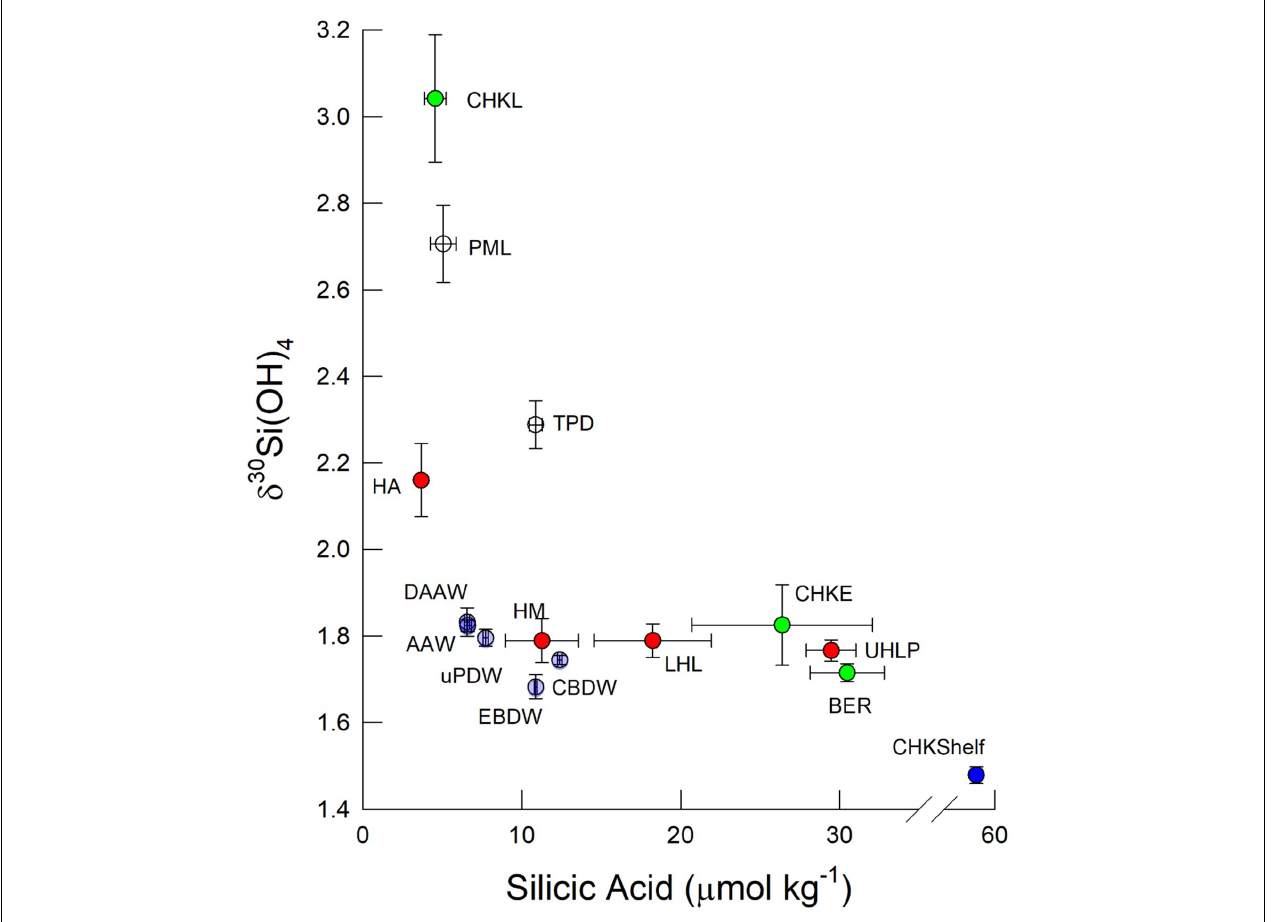
FIGURE 3 | Bivariate plot of δ 30 Si(OH) 4 and silicic aid concentration for water masses within the Arctic Ocean measured on GN01. Symbols represent means and uncertainty bars are one standard error of the mean. Color coding denotes water masses as follows: Green symbols denote data from the Bering Strait (BER) and Chukchi Sea (CHK) where samples from the Chukchi Sea are separated into those sampled early (CHKE) and late (CHKL). Blue symbols represent near bottom samples from the Chukchi Shelf break at station 61 (CHKShelf). White symbols are surface waters of the deep basins separated into the Polar Mixed Layer (PML) outside the Trans Polar Drift and PML waters within the Drift (TPD). Red symbols are halocline waters from the Amundsen Basin (HA), Makarov Basin (HM) and the upper and lower halocline of the Canada Basin, UHLP, and LHL, respectively, where the ULHP denotes UHL waters with > 18 µ mol kg − 1 silicic acid. Light purple symbols denote intermediate waters as follows: Arctic Atlantic Waters (AAW) Deep AAW (DAAW) and upper Polar Deep Water (uPDW) and deep waters: Canada Basin Deep Water (CBDW) and Eurasian Basin Deep Water (EBDW).